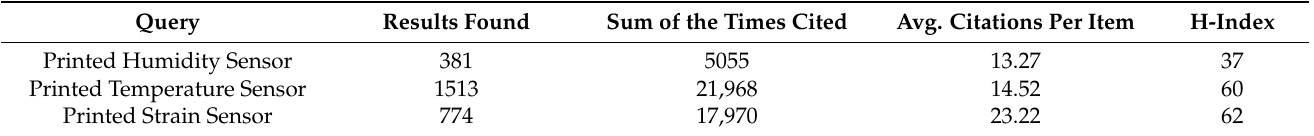
Figure 3. Total citations per year in the range 2014–2020 for “Printed Humidity Sensor”, “Printed Temperature Sensor” and “Printed Strain Sensor”. Year 2013 had less than 200 items and is not displayed. Table 1. Search results (publications) from Web of Science for “Printed Humidity Sensor”, “Printed Temperature Sensor” and “Printed Strain Sensor” between